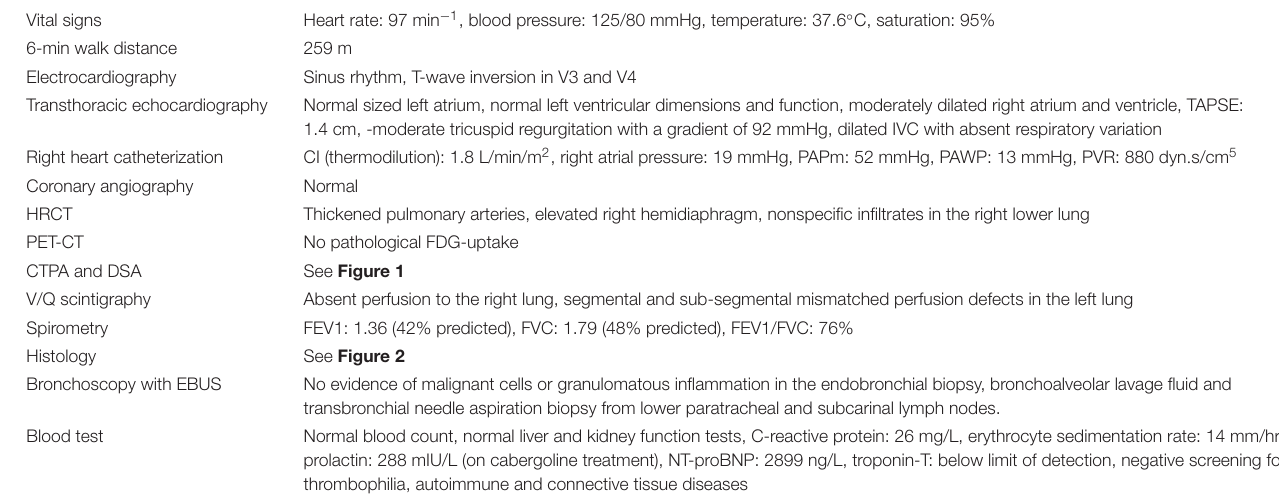
TABLE 1 | Summary of main